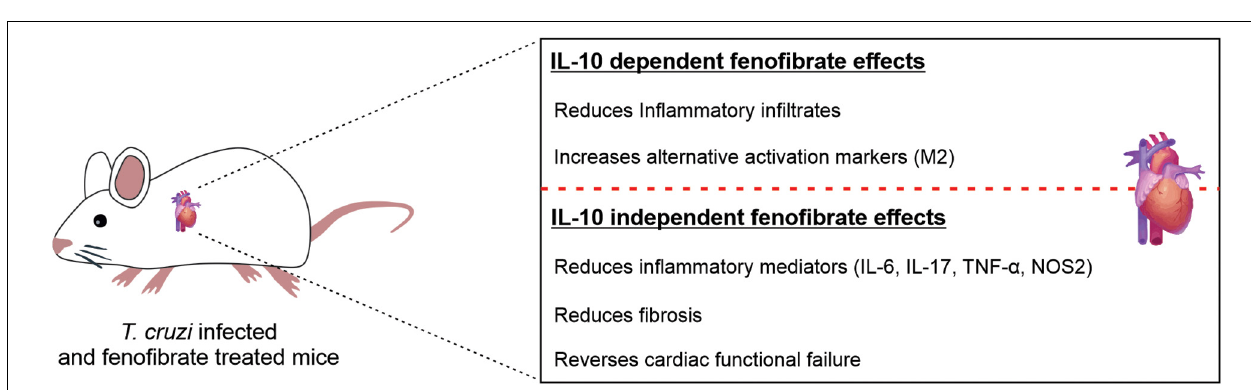
FIGURE 11 | Fenofibrate exerts IL-10 dependent and IL-10 independent effects. The reduction of the inflammatory infiltrate extension and the increase in the expression of M2 markers are IL-10-dependent effects of fenofibrate, while the reduction of proinflammatory mediators expression, cardiac fibrosis and the restoration of cardiac function are IL-10 independent